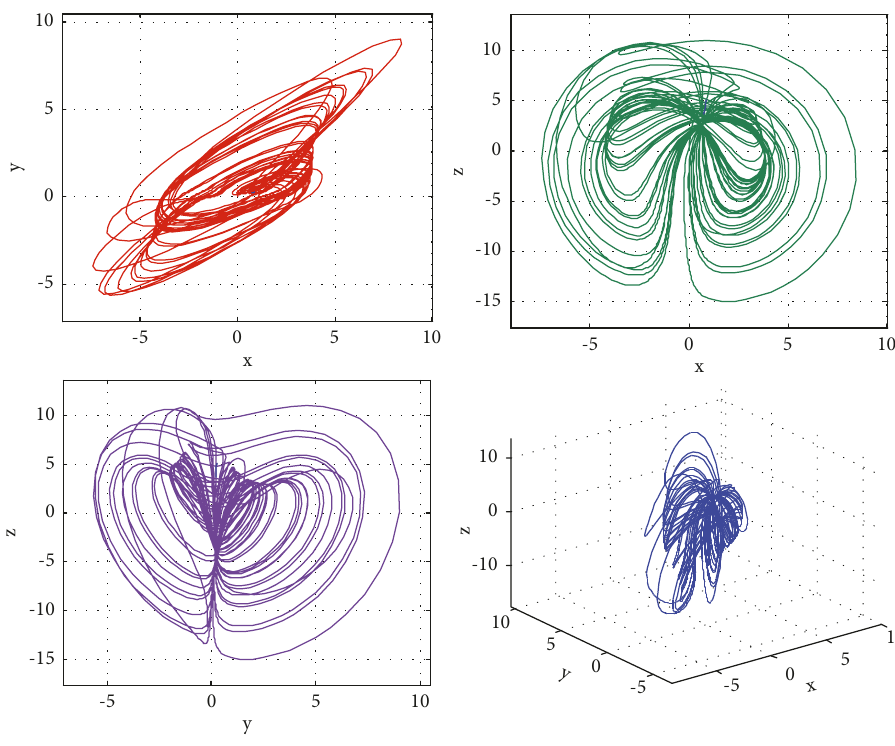
Figure 5: Phase portraits for x-y, x-z, y-z, and x-y-z.